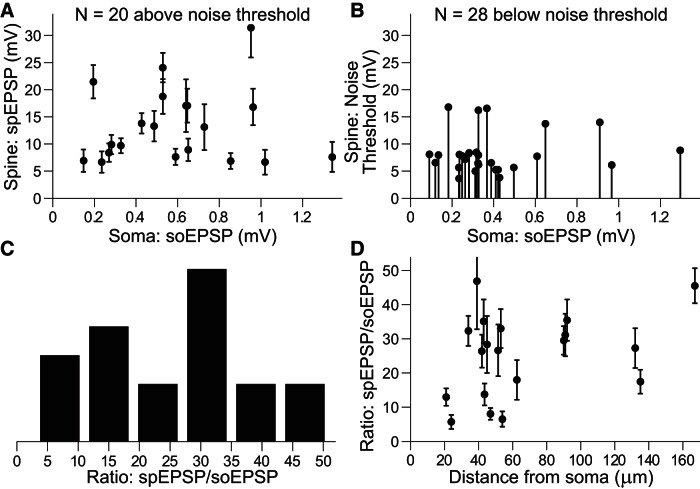
Uncaging-evoked EPSP amplitudes in the spine versus the soma. A, Uncaging-evoked spEPSP amplitude versus the somatic soEPSP amplitude for spines with VSD signal above the detection threshold based on noise estimates (2.5 × σnoise, N = 20 spines). Error bars correspond to SD from time-series data, σnoise. B, Stem plot showing the 2.5 × σnoise threshold, which corresponds to the maximum voltage in the spine evoked by glutamate-uncaging, versus the somatic soEPSP for spines where the VSD signal was below the detection threshold (N = 28 spines). C, Histogram of the ratio of spine to somatic EPSP amplitudes. The mean amplitude ratio was 25.3 ± 12.2. D, Ratio of spine to somatic EPSP amplitudes versus distance from the soma.